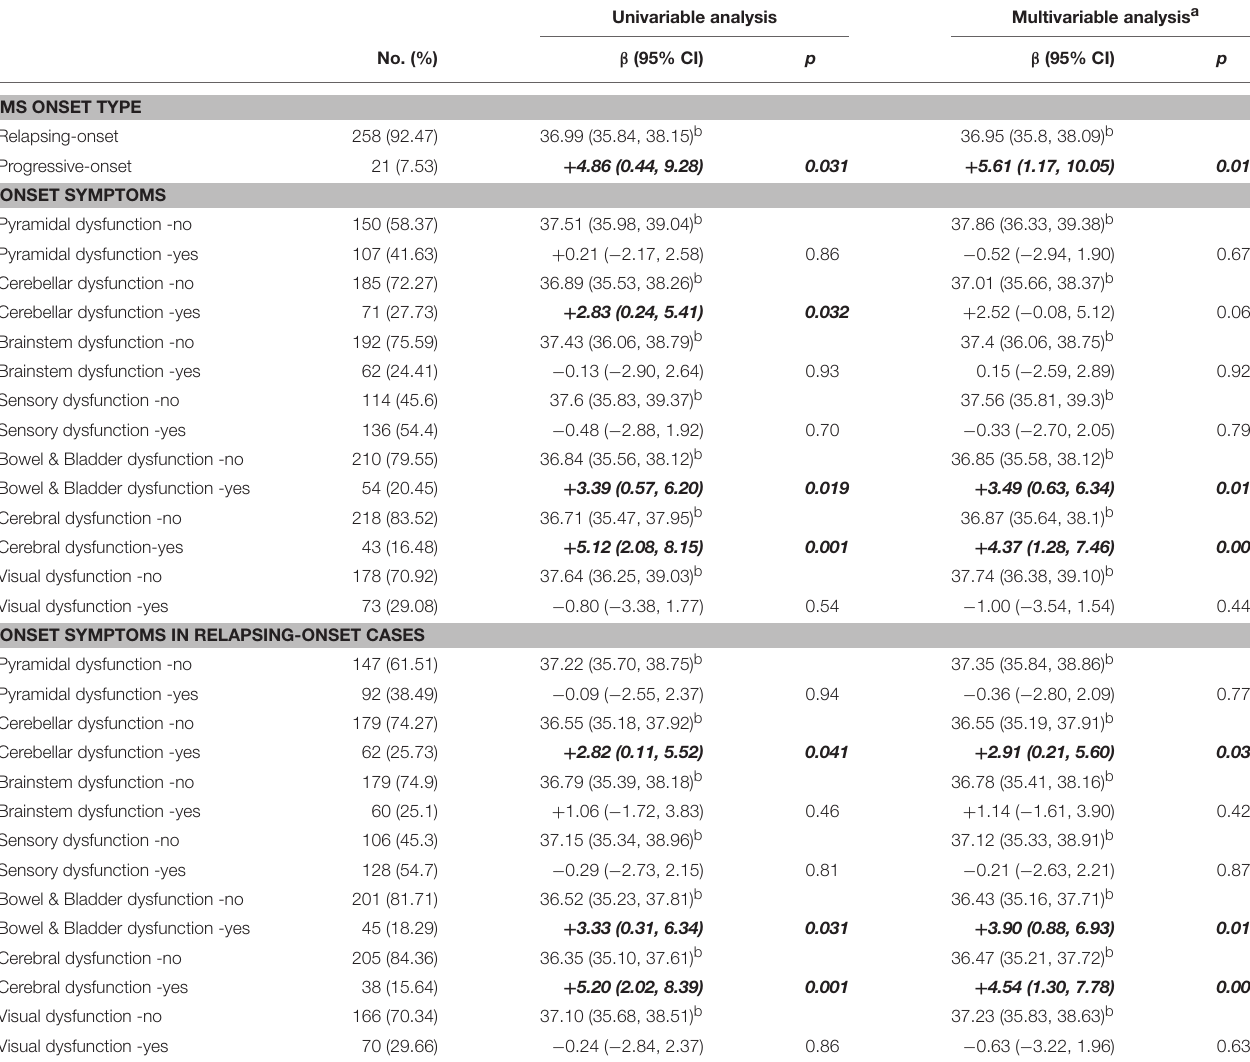
TABLE 2 | Associations between onset type and initial symptomatology and age of symptom onset. Univariable analysis Multivariable analysis